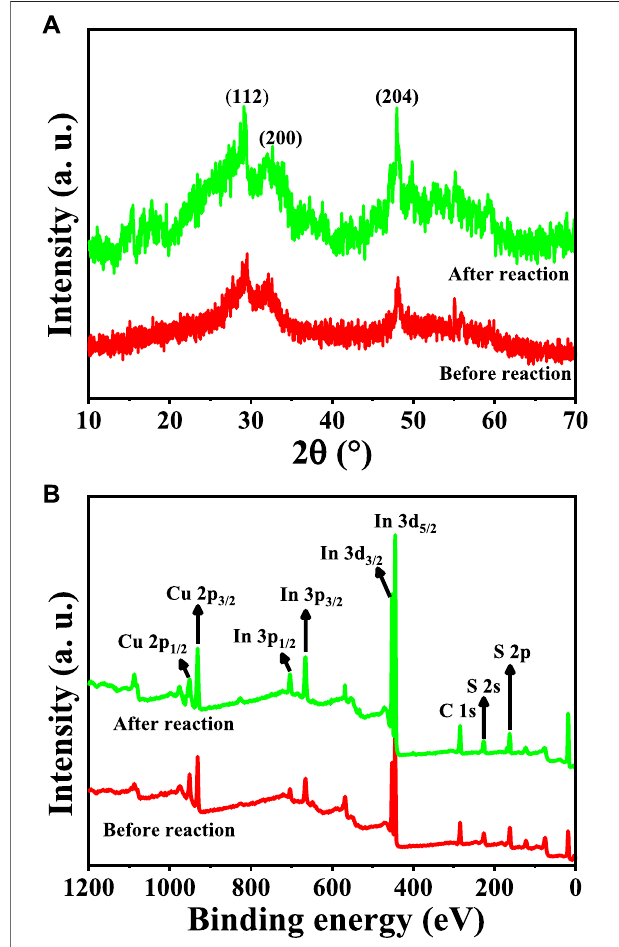
FIGURE12|(A) XRDpatternsand (B) surveyXPSspectraoftheCuInS 2 before and after the cycle